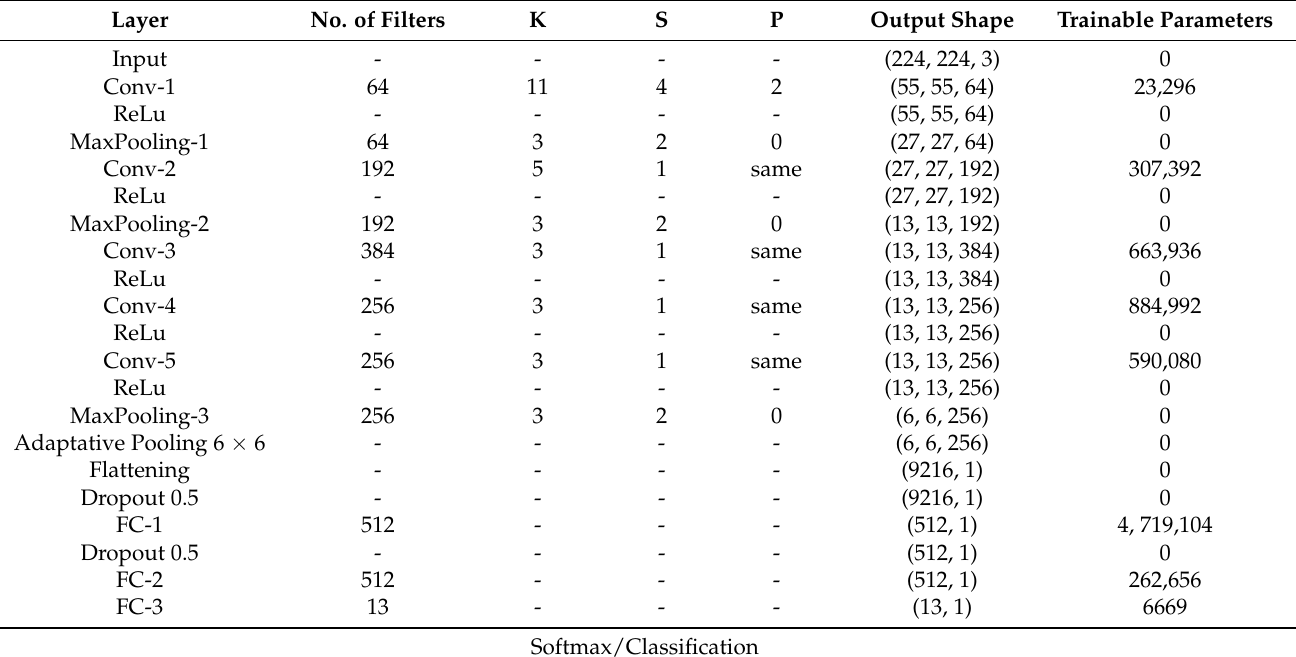
Table 1. Summary of the proposed network (K: Kernel, S: Stride, P: Padding).